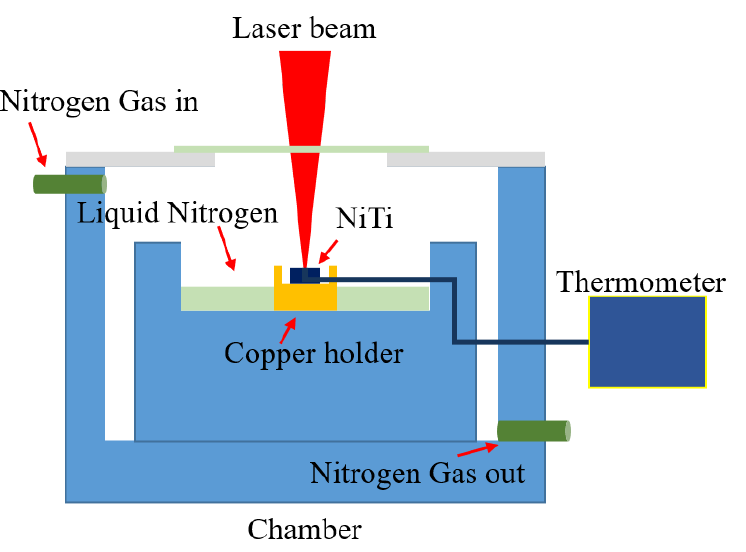
Figure 1. The schematic diagram of the laser nitriding process on NiTi alloy. Table 1. The laser parameter for different NiTi